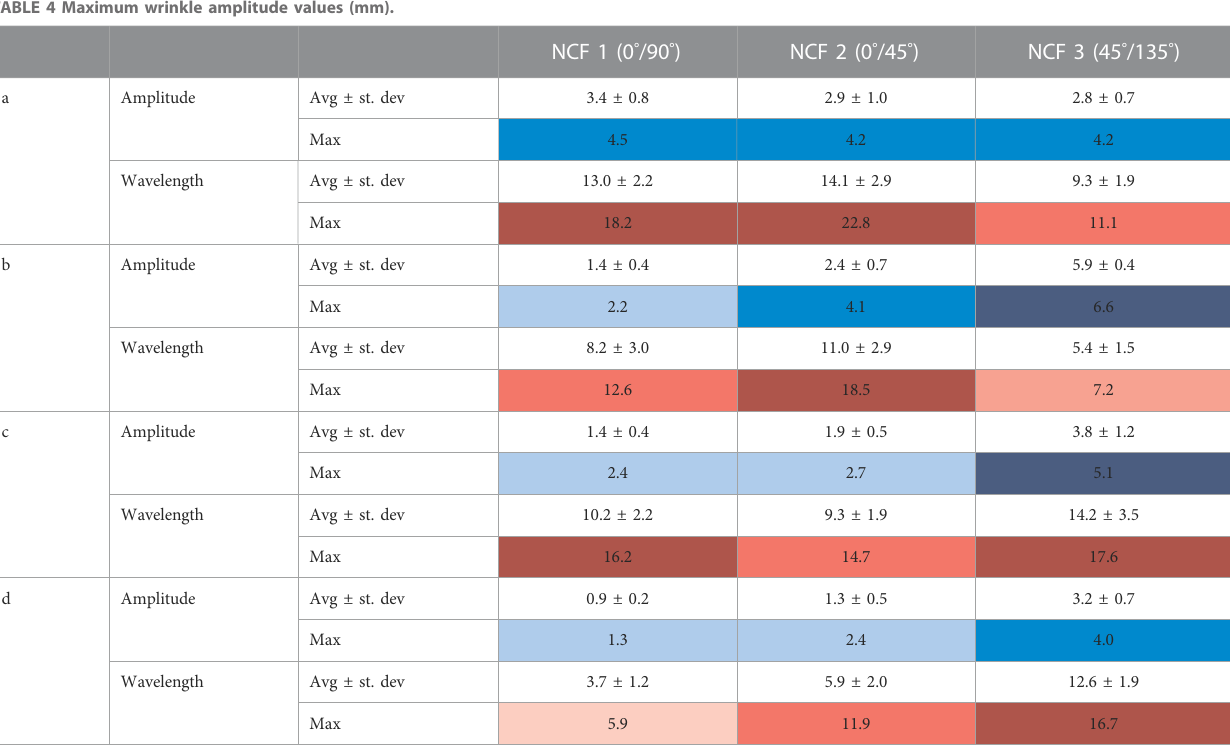
TABLE 4 Maximum wrinkle amplitude values (mm).